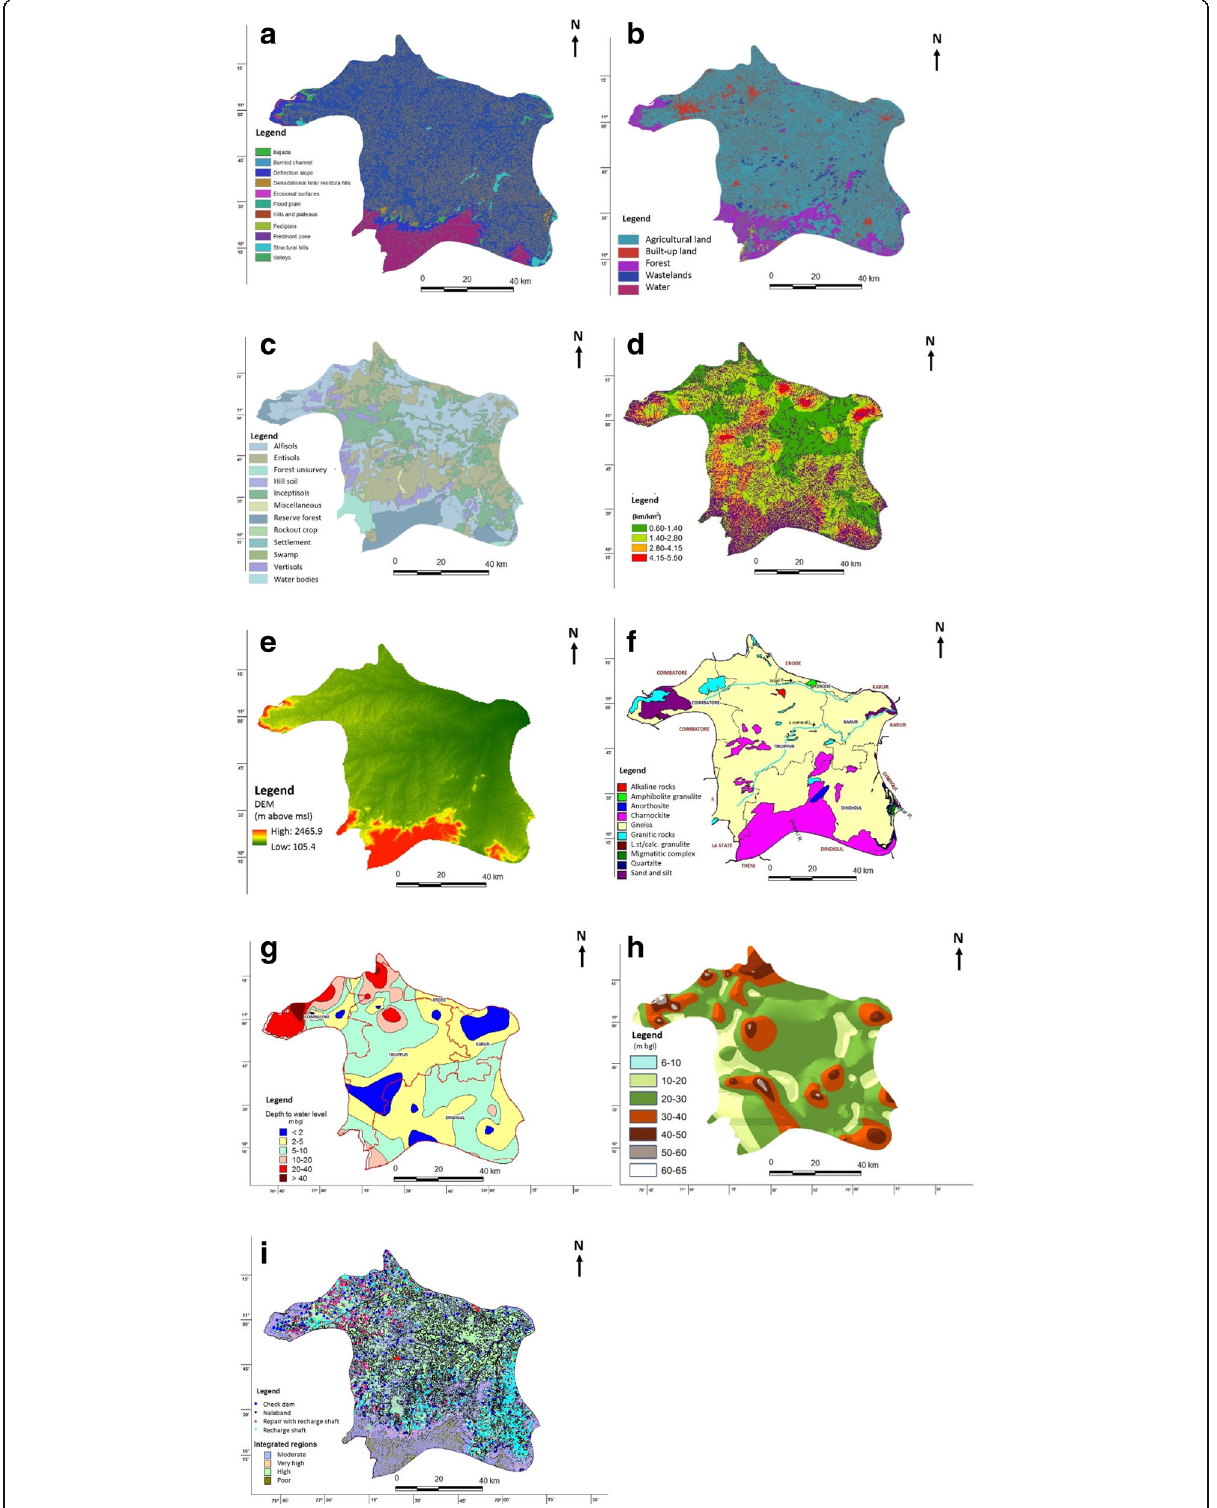
Fig. 3 Amaravathi aquifer system. ( a ) Geomorphological map, ( b ) Land use/land cover map, ( c ) Soil cover map, ( d ) Drainage map, ( e ) Elevation map, ( f ) Geology, ( g ) Post Monsoon water level map, ( h ) Depth to Weathering map, ( i ) Groundwater management